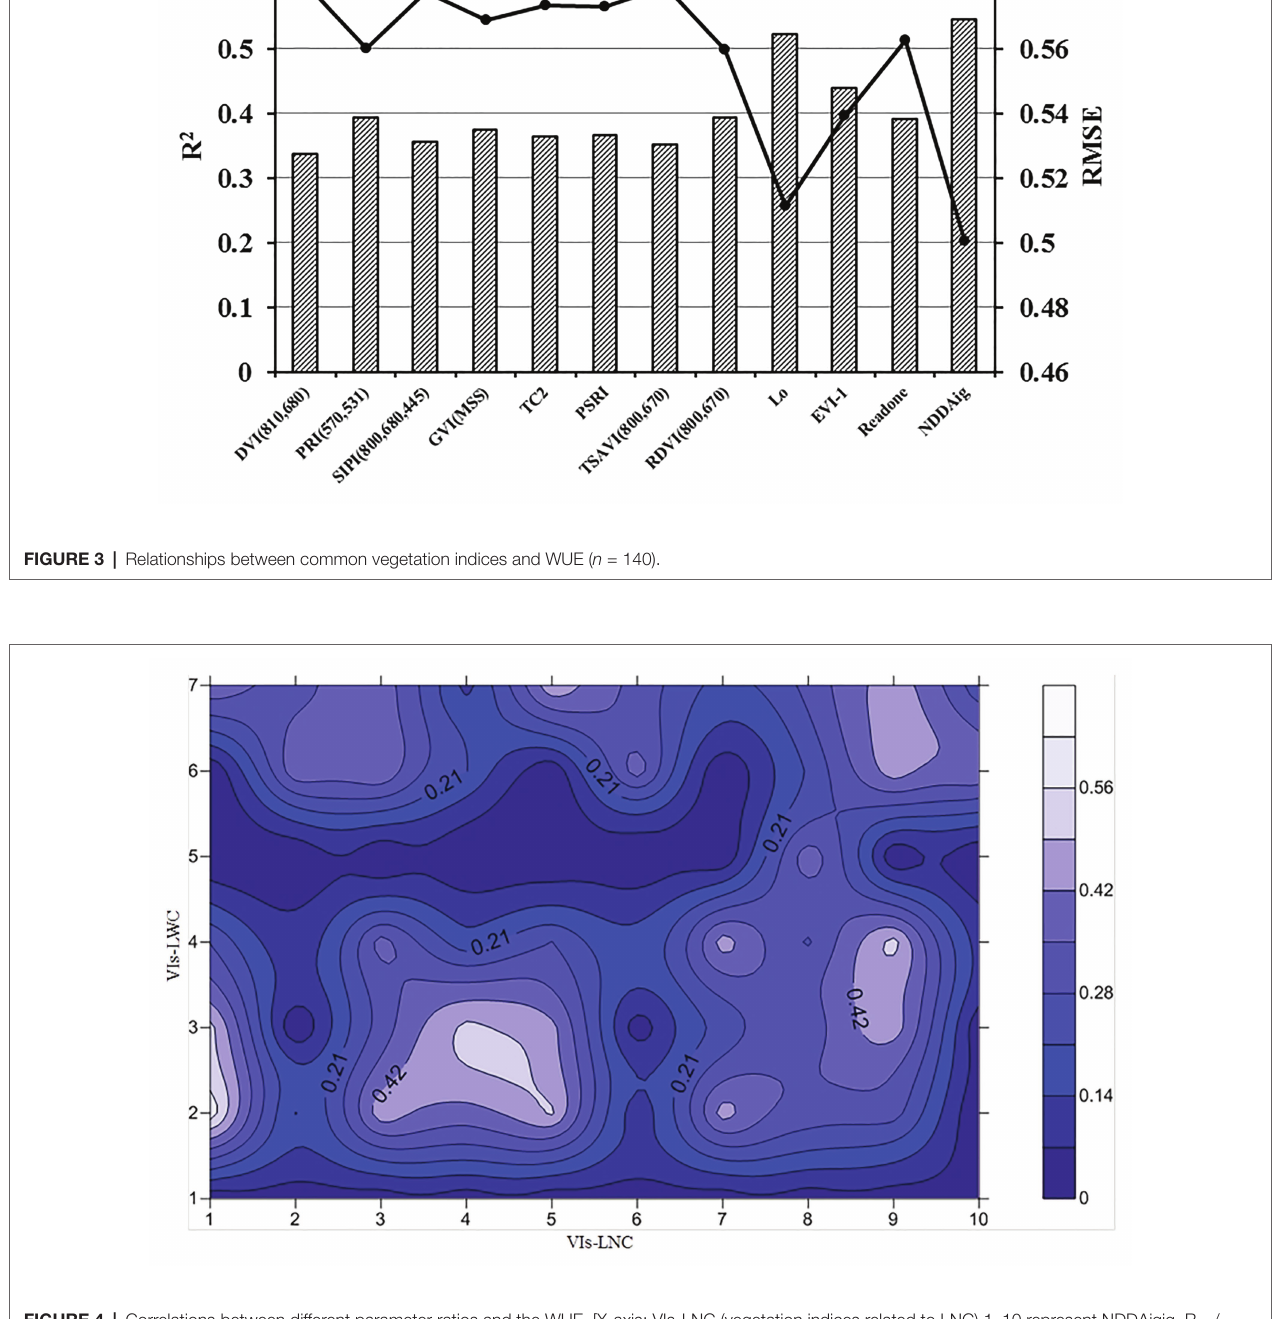
three indicators ( R 2 , RMSE, and RE). The prediction ability is shown as the ratio between predicted and observed values in Figure 9 . The WUE model using NDDAig ( R 2 = 0.602,